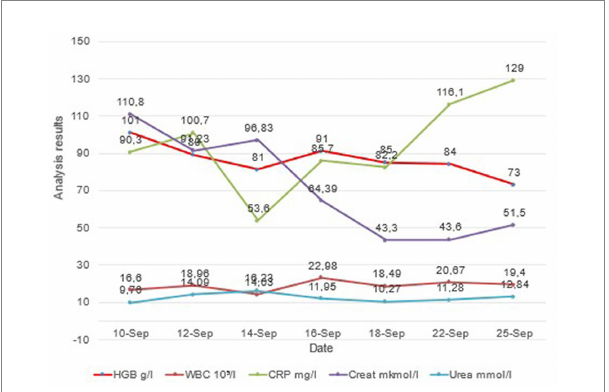
FIGURE 4 The dynamics of tests from the moment of the patient’s admission to the